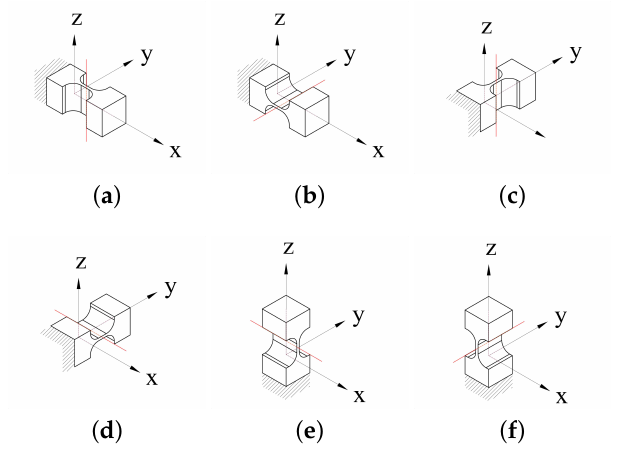
Figure 2. Definition of in-plane and out-of-plane revolute joints using SaNFHs. ( a ) In-plane R ; ( b ) out-of-plane R ; ( c ) in-plane R ; ( d ) out-of-plane R ; ( e ) out-of-plane R ; ( f ) out-of-plane R